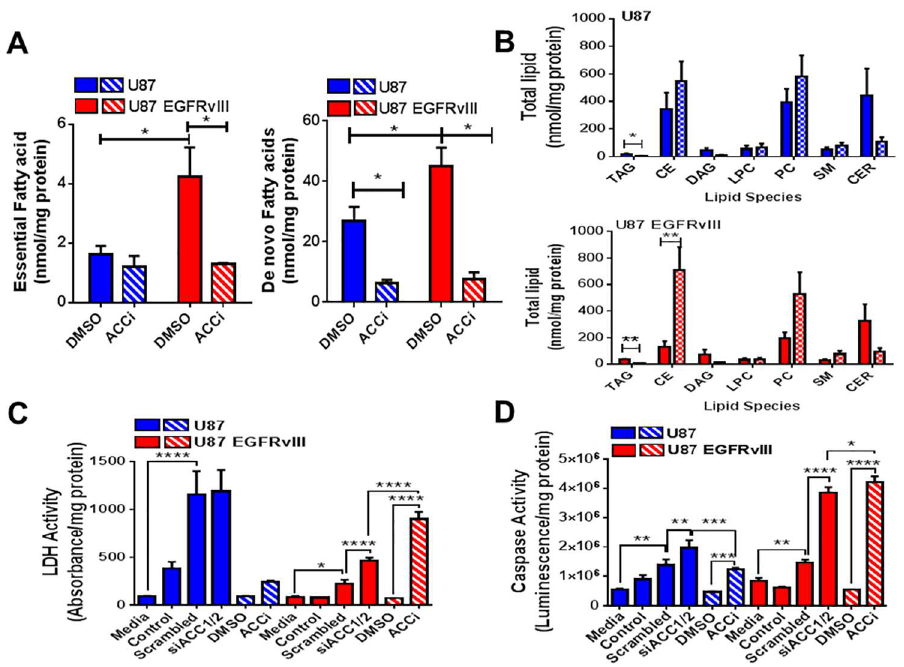
Fig 5. Inhibition of ACC affects lipids content, cell viability and triggers U87 and U87 EGFRvIII cell death. (A) Essentialfatty acid (C18:2), left panel, and de novo fatty acids (C16:0, C16:1 and C18:0), right panel, in U87 and U87 EGFRvIII cells treated with 30 μ M ACCi or DMSO control for 144 hours as assessedby UPLC MS/MS. Data are represented as nmol/mg protein. Each data point representsmean +/- sem, n = 3. * p < 0.05.(B) Effect of 144 hours treatment with 30 μ M ACCi (patternedbars) or DMSO control (solidbars) on total cellularlipid speciesin U87 (top panel)and U87 EGFRvIII (lower panel)cells as assessedby UPLC-MS/ MS. Data are expressed as nmol/mg protein. Each data point representsmean +/- sem, n = 3. * p < 0.05, ** p < 0.01.(C) Cellularcytotoxicity after 144 hours treatment with either 30 μ M ACCi, DMSO control, a combination of siRNAs targeted to ACC1 and ACC2 (siACC1/2) or scrambledsiRNA control on U87 and U87 EGFRvIII as assessedby measurement of lactate dehydrogenase releaseinto the assay media. Control samples were treated with transfectionreagent only. Media samples were not treated with transfection reagent or DMSO. Data are representedas absorbanceunits per milligramof total protein per well. Each data point represents mean +/- sem, n = 3. * p < 0.05, **** p < 0.0001. (D) Cellularcaspase activity after 144 hours treatment with either 30 μ M ACCi, DMSO control, a combination of siRNAs targeted to ACC1 and ACC2 (siACC1/2) or scrambledsiRNA control on U87 and U87 EGFRvIII cells as assessedby measurement of caspase 3/7 activity. Controlsamples were treated with transfectionreagentonly. Media samples were not treated with transfectionreagent or DMSO. Data are representedas luminescenceper milligramof total protein per well. Each data point represents mean +/- sem, n = 3. * p < 0.05, ** p < 0.01, **** p <